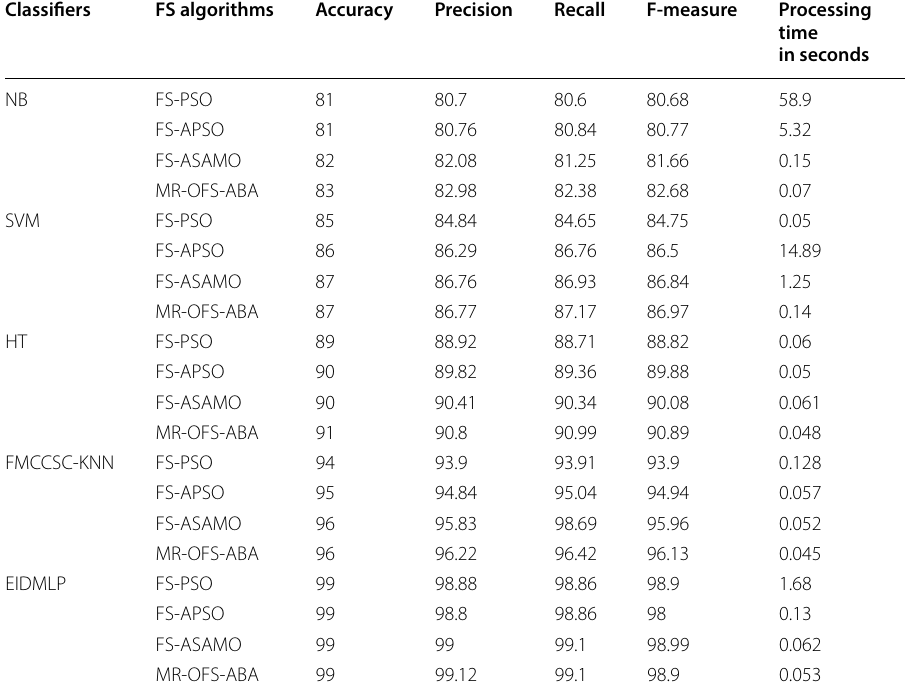
Table 2 Classification results of Arcene